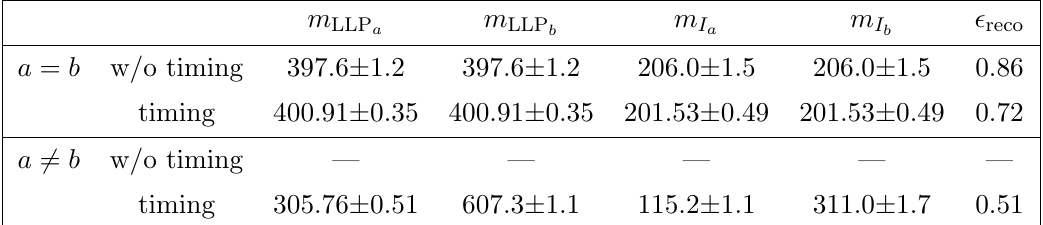
Table 2 . Reconstructed masses and reconstruction e(cid:14)ciencies for the identical LLPs case ( a = b ) and the non-identical LLPs case ( a 6 = b ). The masses are obtained from the pole mass of a Breit- Wigner probability distribution function for ( a = b ), and a Crystal Ball probability distribution function is used for ( a 6 = b ). The uncertainties are smaller than what would typically be seen on an experiment due to not incorporating the e(cid:11)ects of backgrounds, the use of a fast simulation and other related